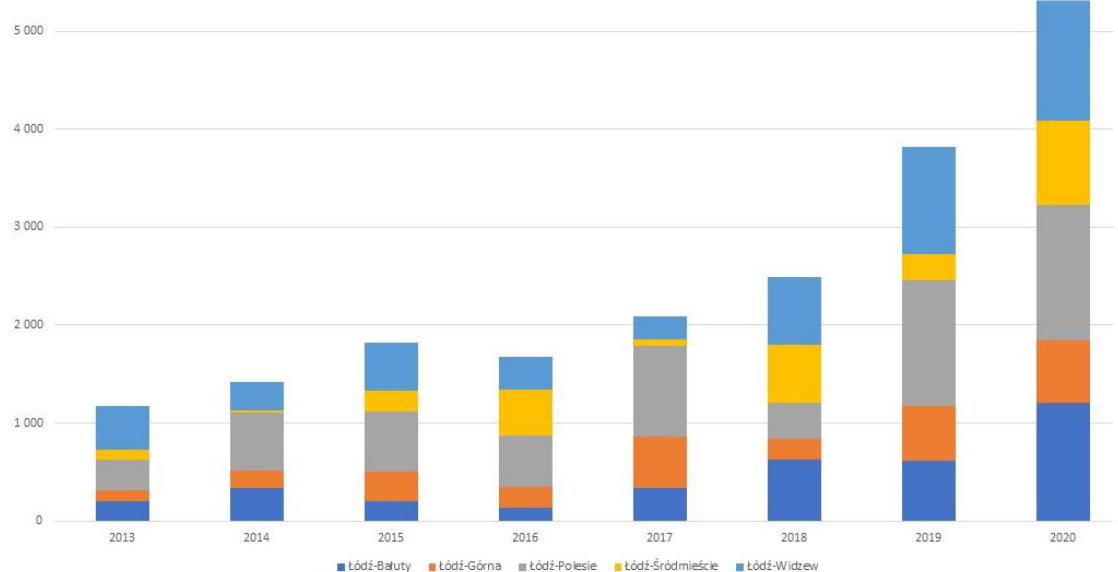
Fig. 7. Number of development dwellings commissioned for use in Łódź, broken down by districts (Source: Own study based on the LDB)